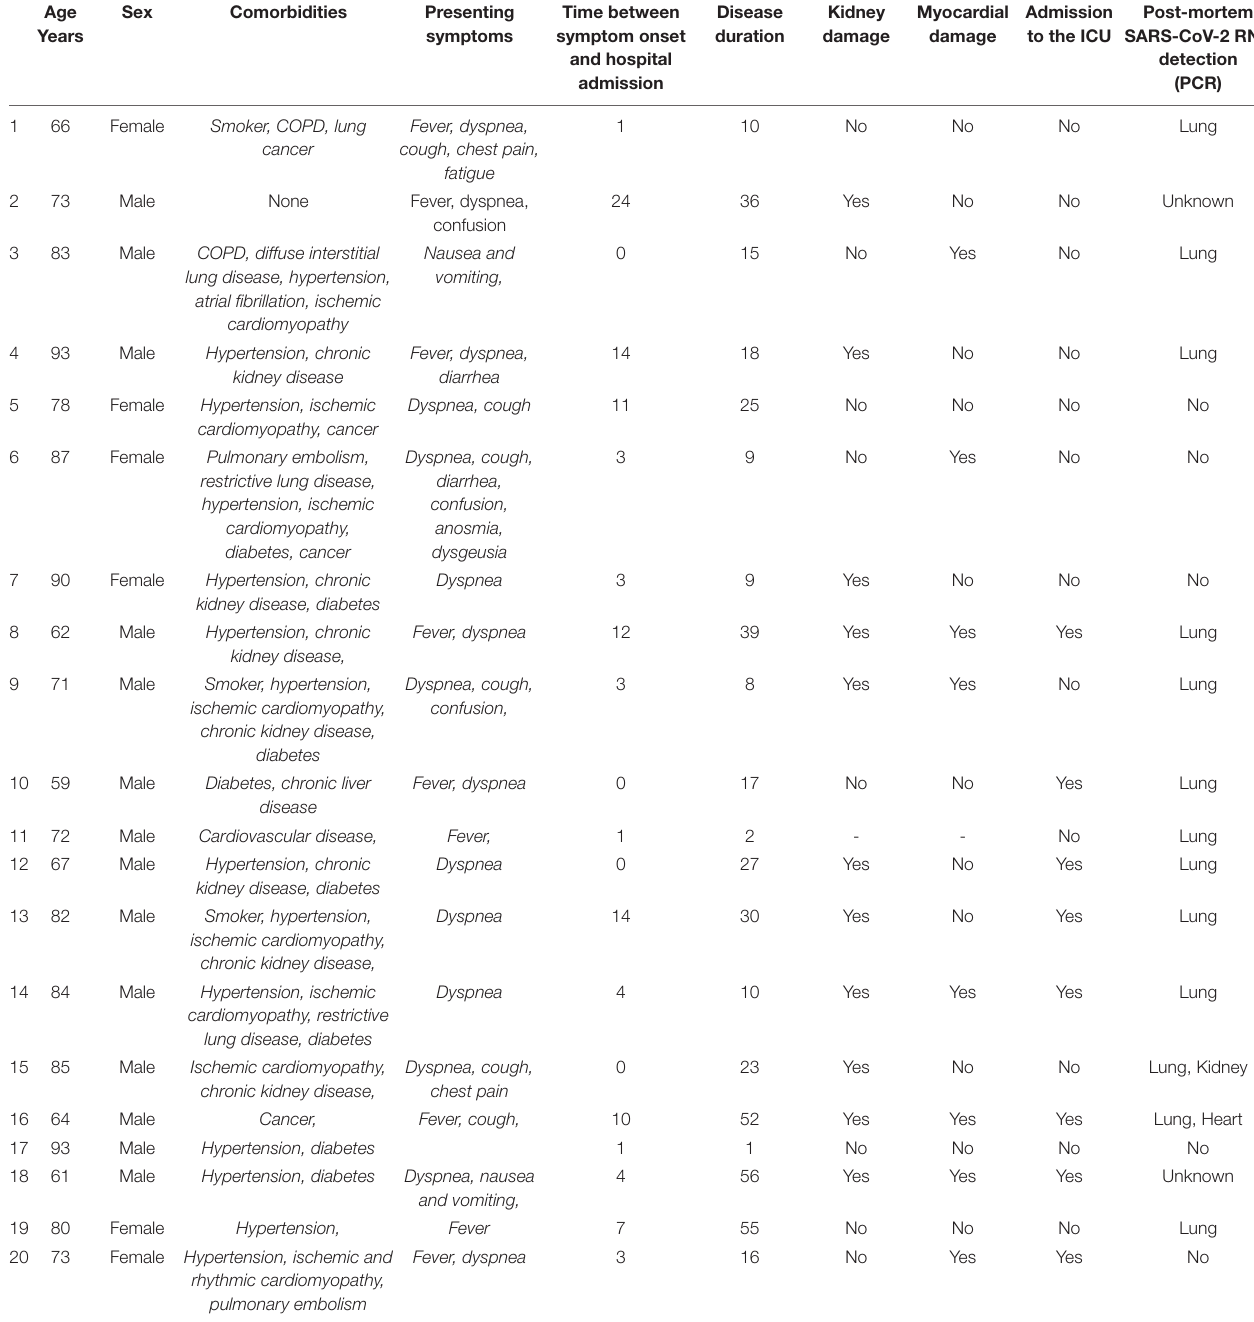
TABLE 2 | Patient characteristics, symptoms, organ failure and